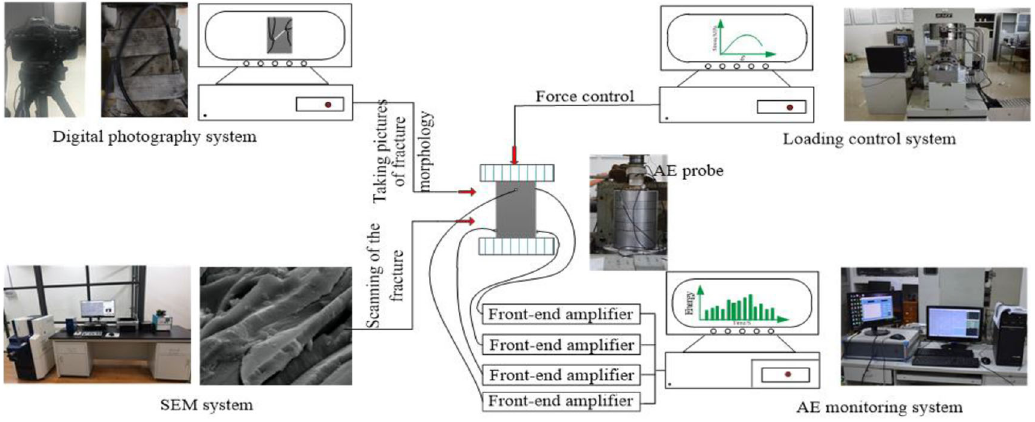
Fig. 2 Loading and monitoring